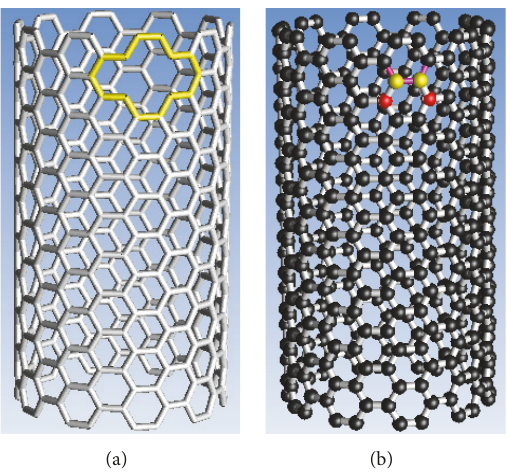
Figure 25: Adaptive editing for nanotube.